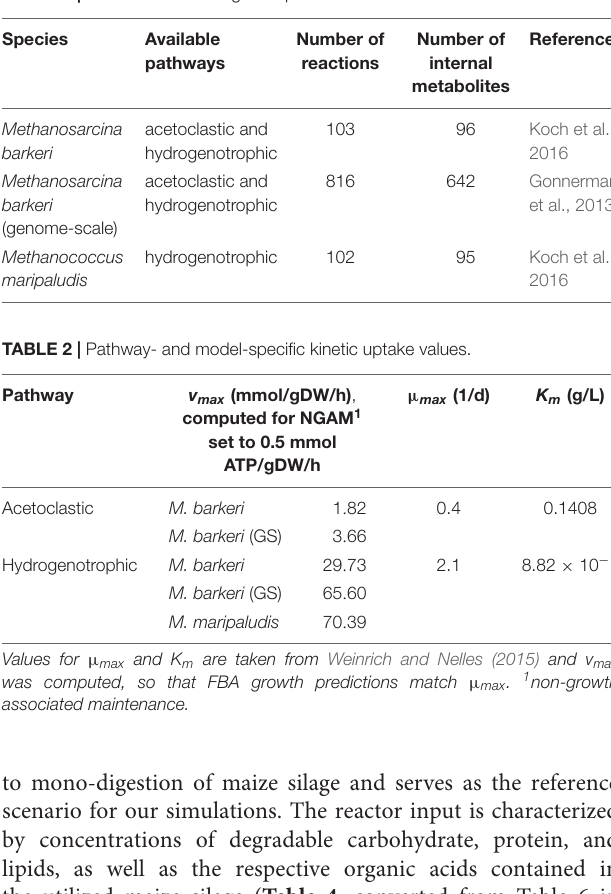
Frontiers in Microbiology |